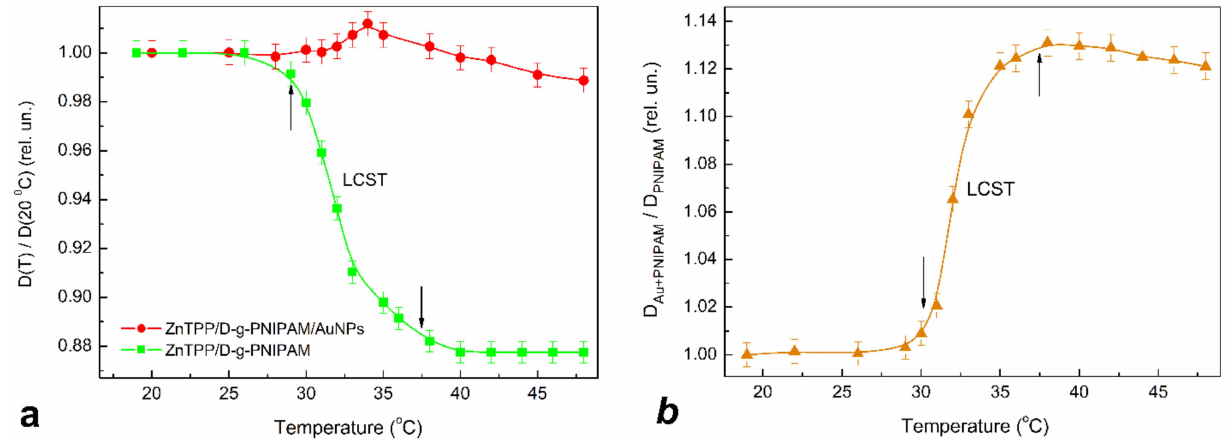
Figure 7. ( a )—Dependence of total (B and Q bands) optical density on temperature for ZnTPP in aqueous solutions of ZnTPP/D-g-PNIPAM (squares) and ZnTPP/D-g-PNIPAM/AuNPs (circles) during heating. ( b )—Dependence of the ratio of total optical densities for ZnTPP in ZnTPP/D-g- PNIPAM/AuNPs and ZnTPP/D-g-PNIPAM on temperature characterizing the impact of Au NPs on ZnTPP light absorption in ZnTPP/D-g-PNIPAM/AuNPs nanosystem. The optical density is normal- ized by value at 20 ◦ C. Arrows show the LCST transition range. Concentrations: ZnTPP—0.001 g/L,